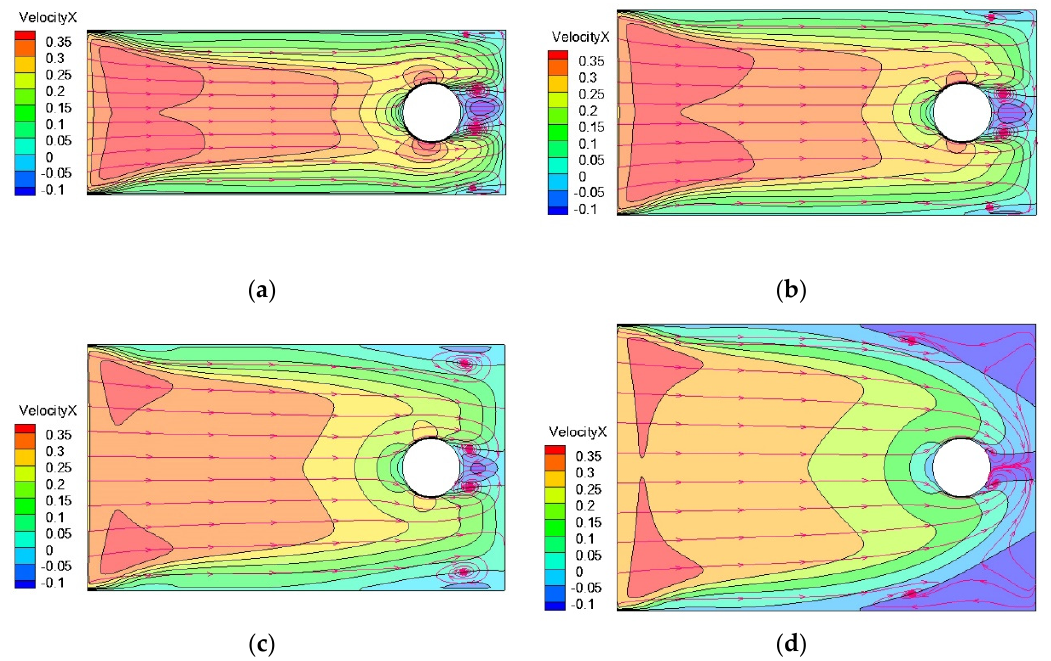
Figure 12. Velocity distribution of section 3-3 with different width. ( a ) Case 5, ( b ) Case 3, ( c ) Case 6 and ( d ) Case 7.